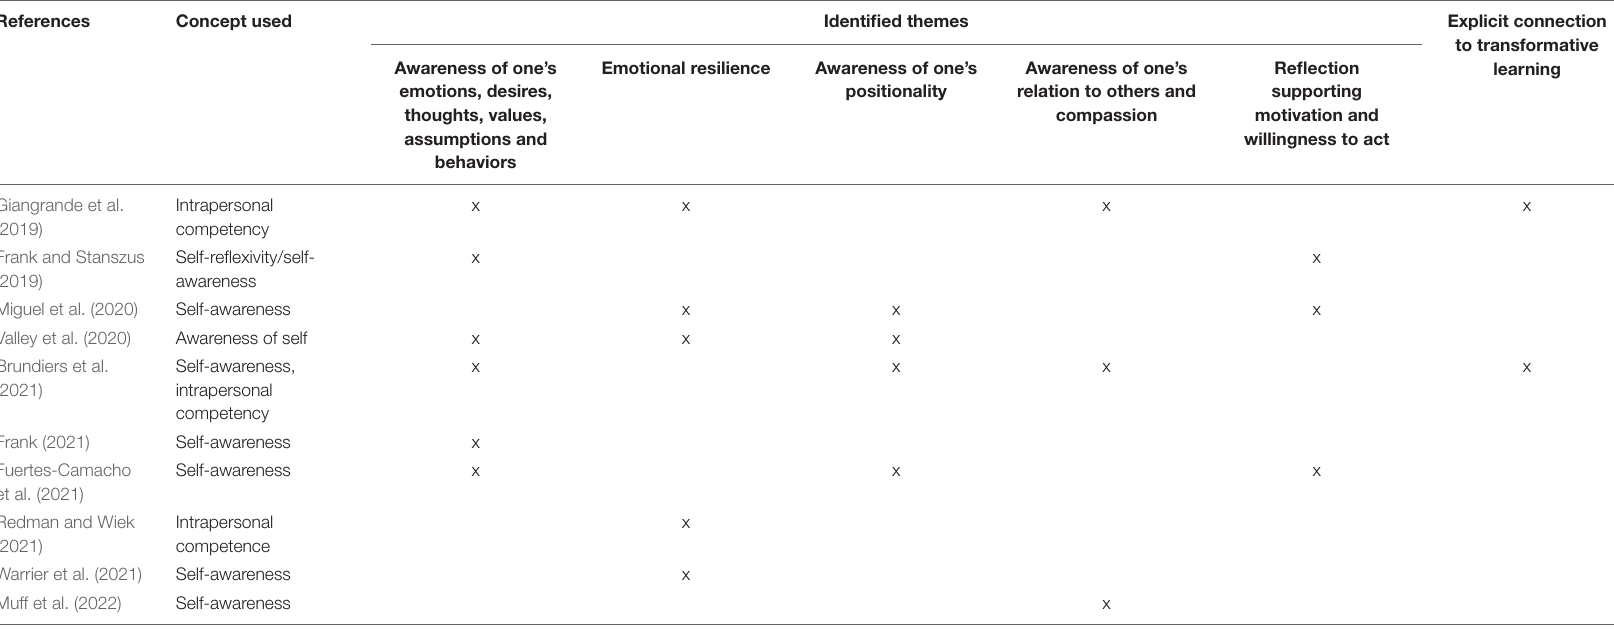
TABLE 1 | Interpretations given to self-awareness and intrapersonal competency and explicit connections between self-awareness and transformative learning (X = the theme was identified in the article/explicit connection between self-awareness/intrapersonal competency and transformative